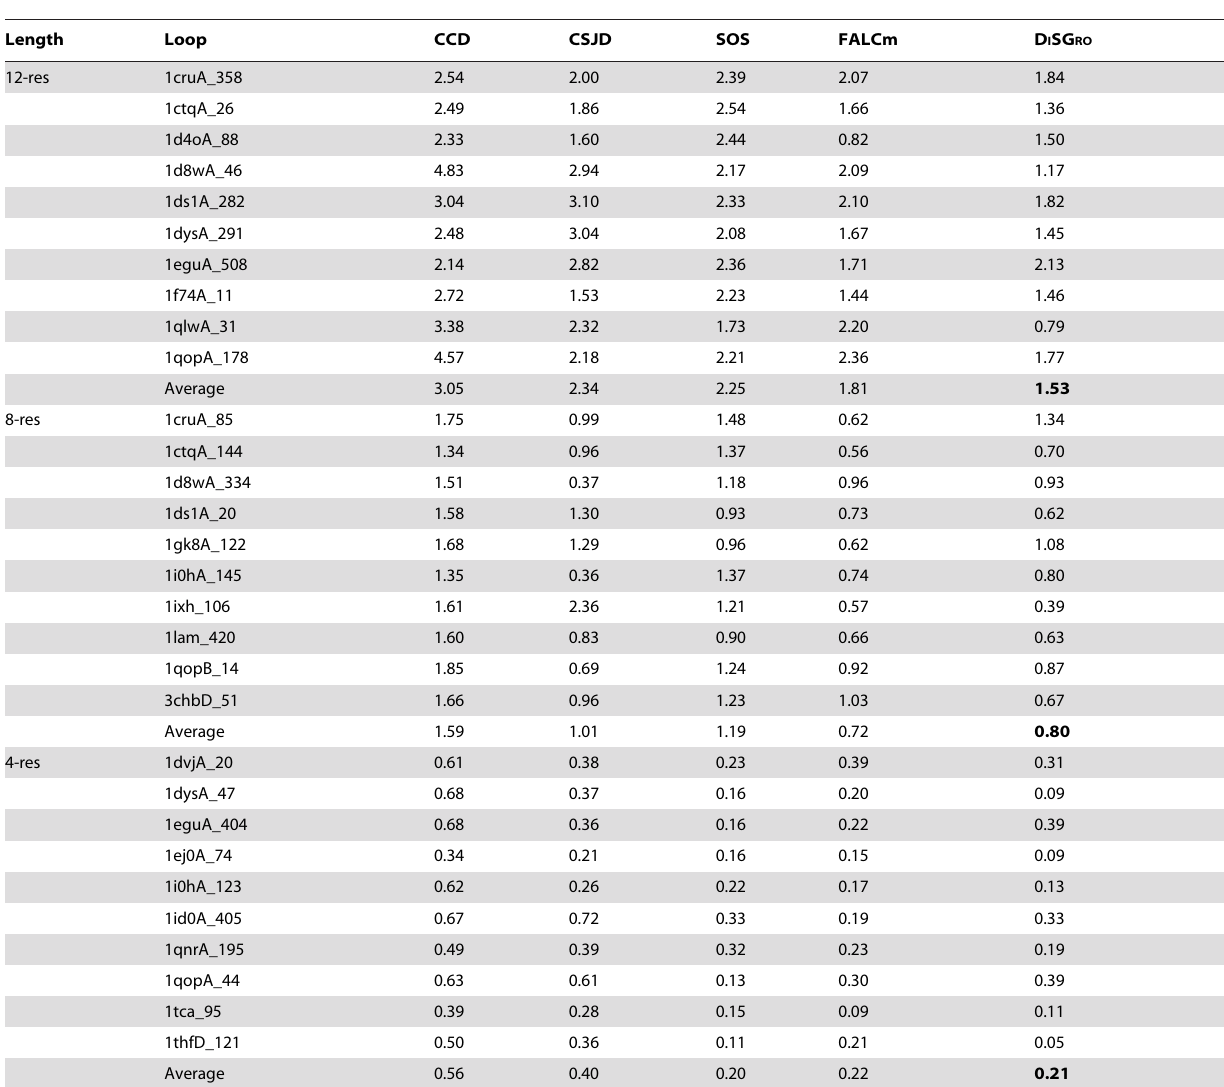
Table 1. Minimum backbone RMSD values of the loops sampled by five different algorithms.